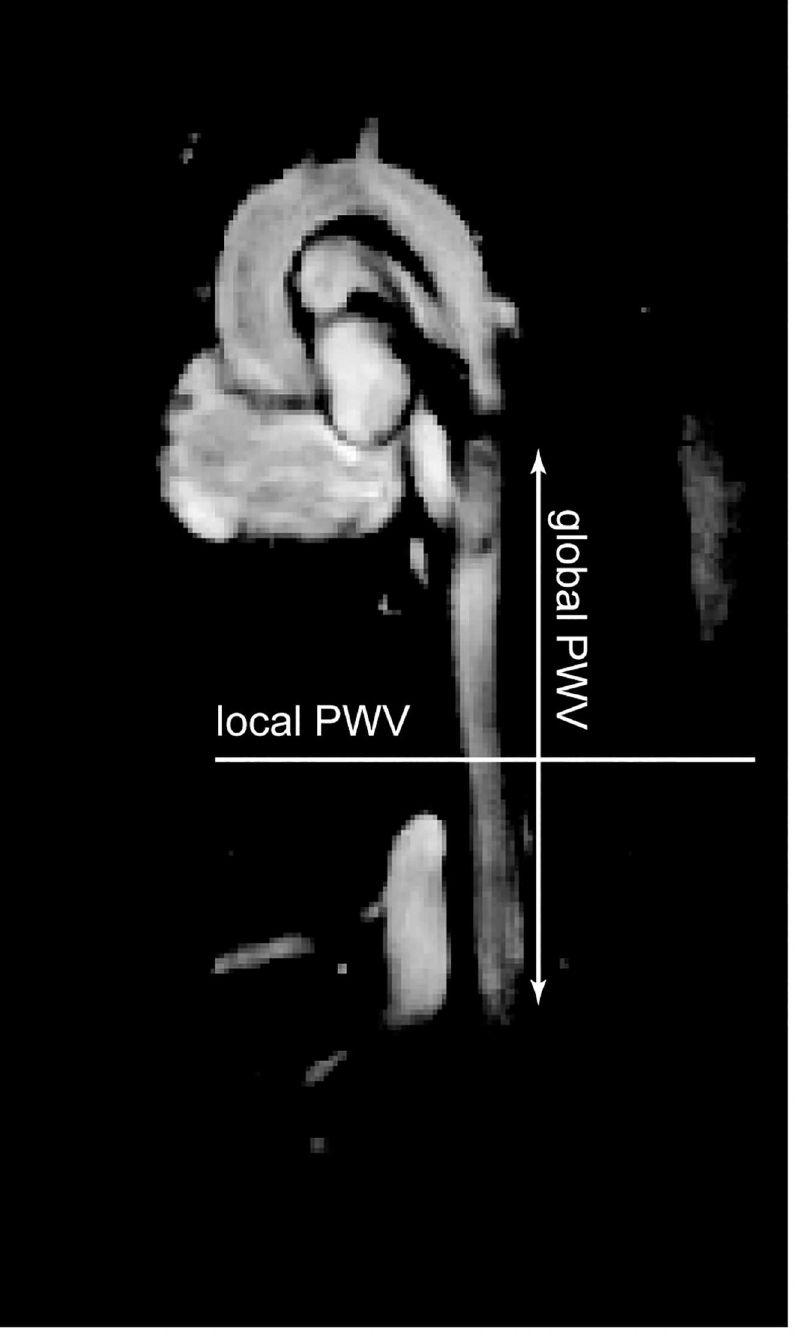
Fig 3. Slice positioning in-vivo. In the abdominal aorta, local PWV was measured in a slice perpendicular to the direction of the vessel. The globalPWV was obtainedfrom a slice parallelto the descending aorta.